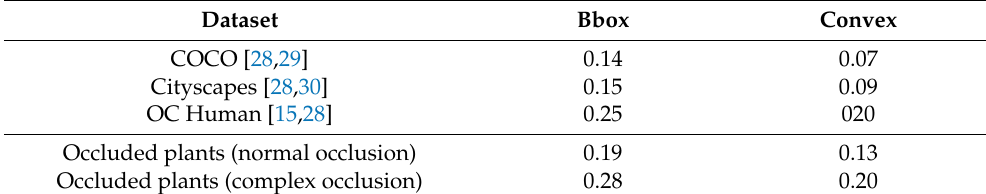
Table 1. Comparison of the OoS measure with different datasets containing images with occlusions.